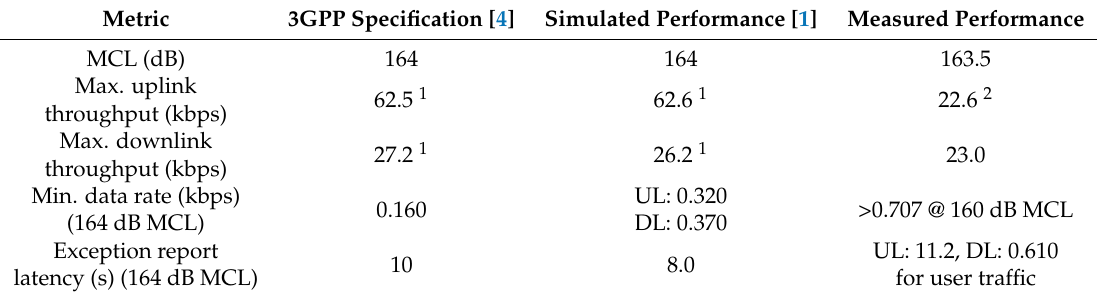
Table 4. Comparison of different NB-IoT QoS parameters in a guard-band